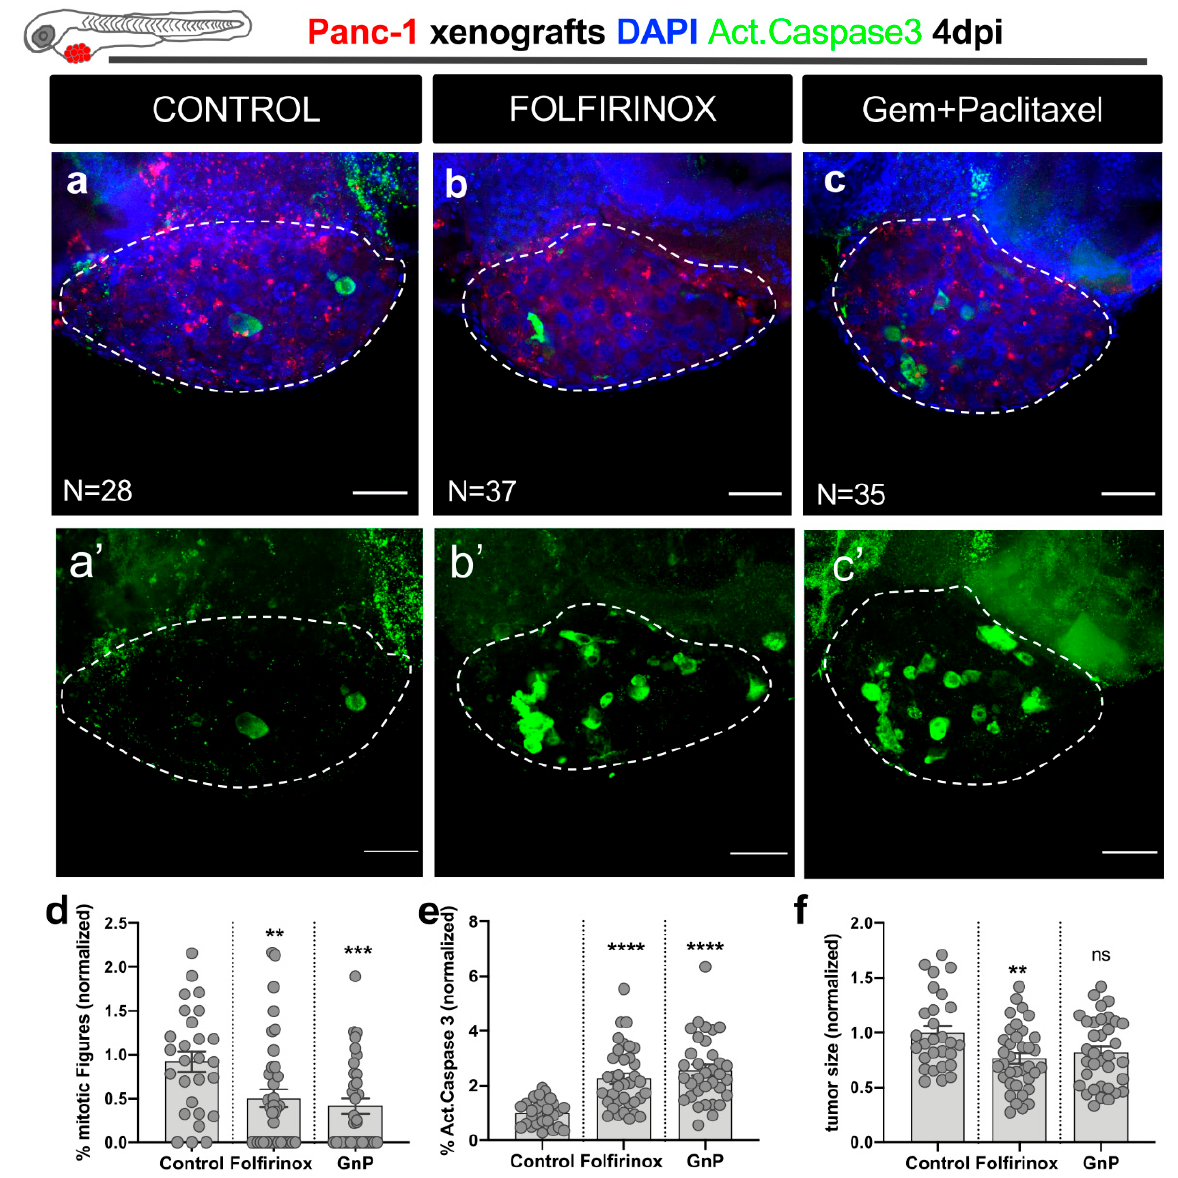
Figure 3. Zebrafish xenografts reveal sensitivity to the major therapeutic options for pancreatic cancer— FOLFIRINOX and gemcitabine plus paclitaxel chemotherapy. At 2 dpf, zebrafish embryos were injected with fluorescently labeled Panc-1 cells in the PVS. At 1 dpi, successfully injected xenografts were submitted to FOLFIRINOX or gem + paclitaxel treatment for three consecutive days and compared to control nontreated xenografts. At 4 dpi, zebrafish xenografts were imaged by confocal microscopy ( a – c ). Maximum Z projections of activated caspase-3 ( a’ – c’ ). Cell proliferation (% of mitotic figures), apoptotic index (% of activated caspase-3 in green), and tumor size (number of tumor cells, DAPI in blue) were analyzed and quantified ( d – f , respectively). Data are shown as mean ± SEM. Statistical analysis was performed using Mann–Whitney test. Statistical results: (ns) > 0.05, ** p ≤ 0.01, *** p ≤ 0.001, **** p ≤ 0.0001. The number of zebrafish xenografts analyzed is indicated in the figure. Results are from 3 independent experiments. Scale bars represent 50 µm. All images are anterior to the left, posterior to right, dorsal up, and ventral down.